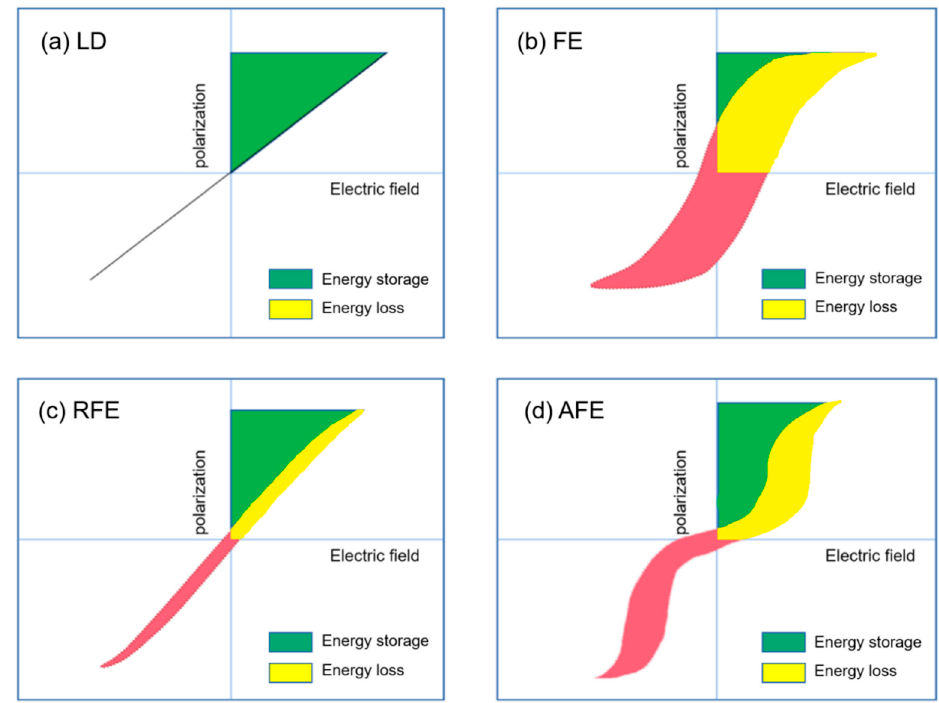
Figure 6. Hysteresis and corresponding energy storage density for ( a ) linear dielectrics, ( b ) ferroelectrics, ( c ) relaxor ferroelectrics and ( d ) antiferroelectrics. The green area represents energy density and the red area refers to the energy loss.